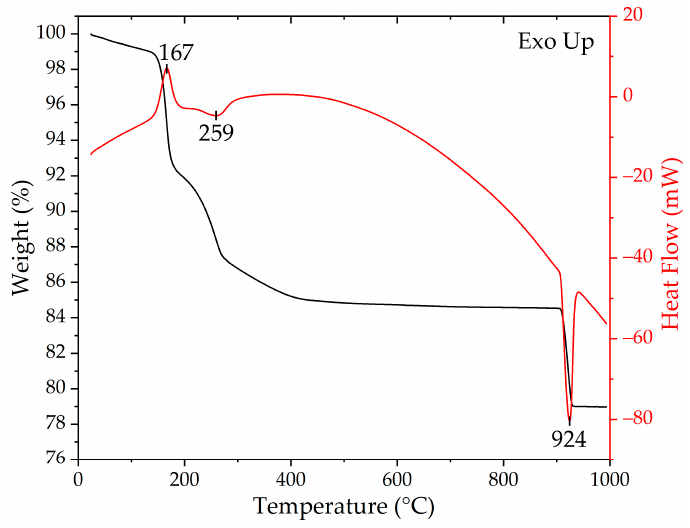
Figure 1. Results of synchronous (TGA/DSC) thermal analysis of the semi-product obtained.